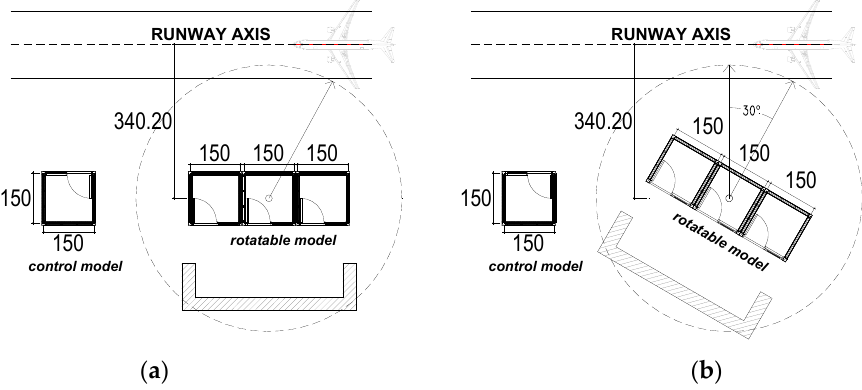
Figure 3. Measurement procedure with building model. ( a ) building model with α facing to runway; ( b ) building model with rotated α .